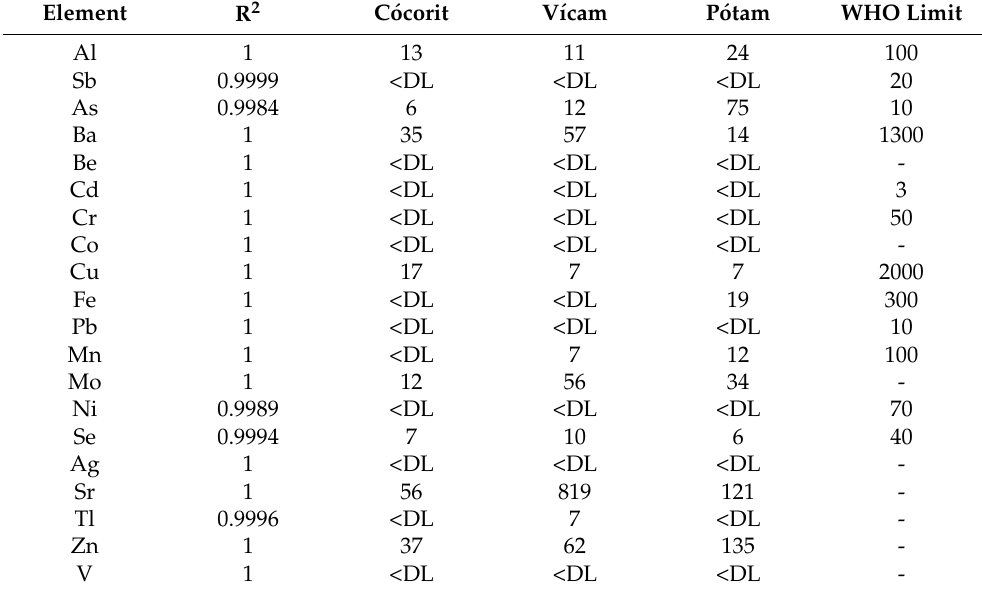
Table 1. Concentration of metal(oid)s in drinking water ( µ g · L − 1 ) provided to mice in this work. The indigenous communities from the Yaqui Valley are P ó tam, V í cam, and C ó corit. WHO limits taken from Guidelines for drinking-water quality: fourth edition incorporating the first addendum. Geneva: World Health Organization; 2017. License: CC BY-NC-SA 3.0 IGO. R 2 correlation coefficient of calibration curve ( n =